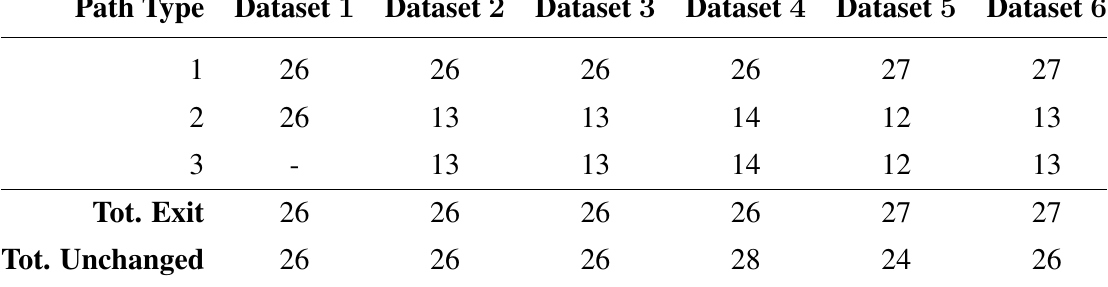
Table 1. Number of experiments for the six different rooms for each user